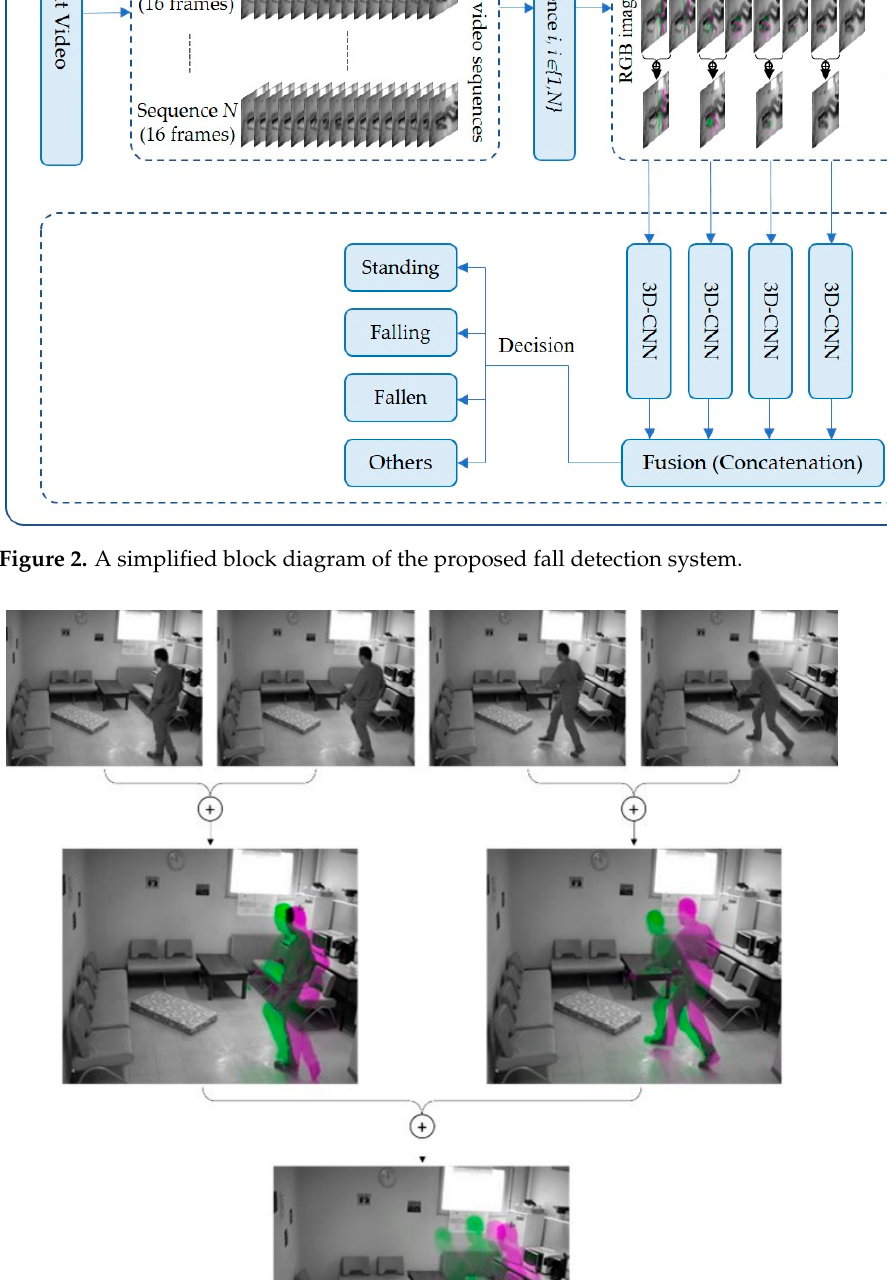
Figure 3. Two-level image fusion of 4 consecutive video frames.